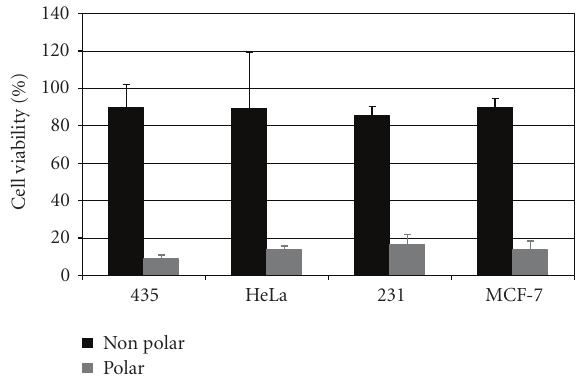
Figure 1: Bioactivity of the nonpolar and polar extracts of Atriplex confertifolia against three human breast cancer cell lines (435, 231, and MCF-7) and a human cervical cancer cell line (HeLa).